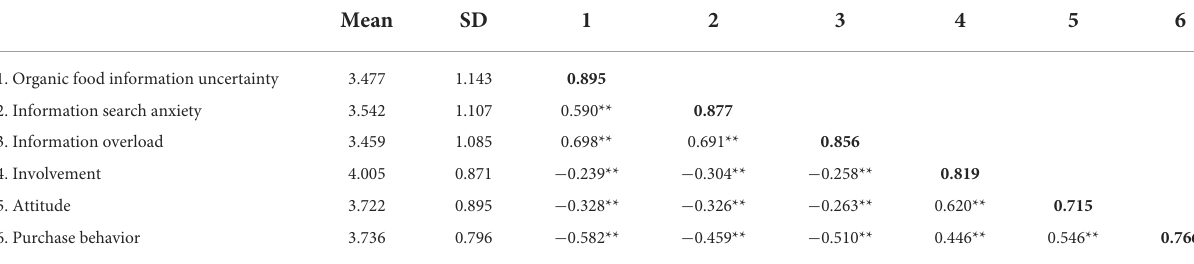
TABLE 3 Means, standard deviations and